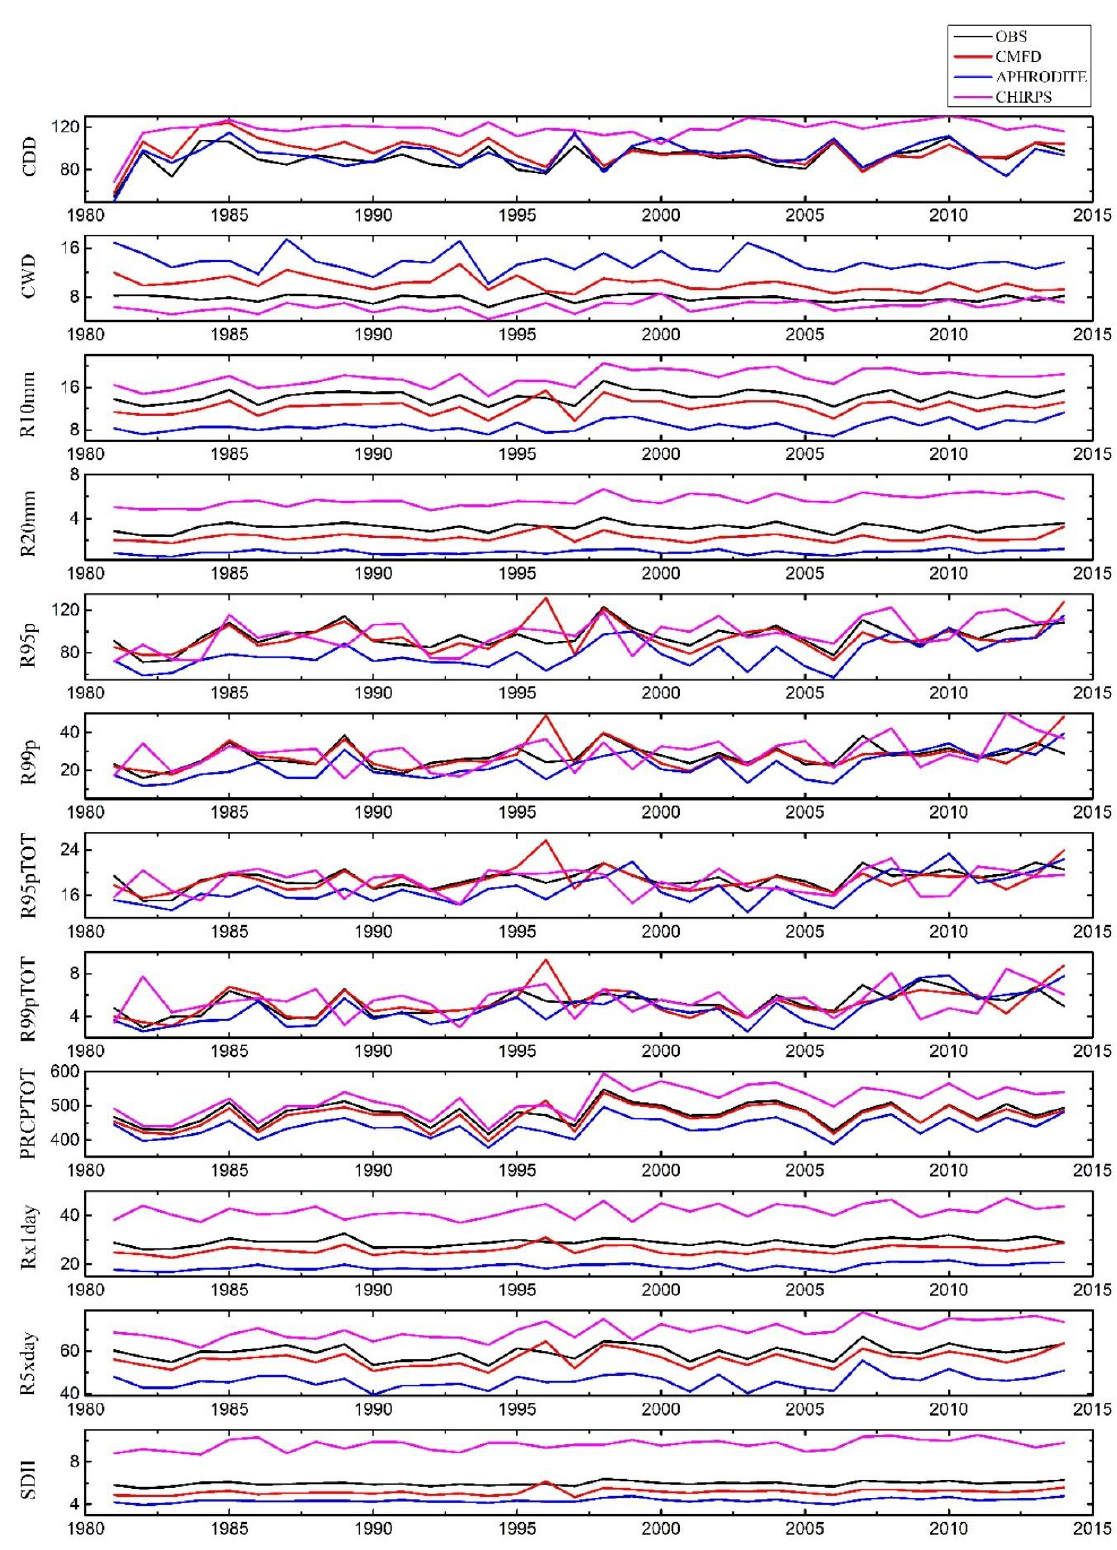
Figure 20. Mean annual rainfall indices of the 101 rain-gauge stations, and the corresponding CMFD, APHRODITE, and CHIRPS estimates from 1981 to 2014.